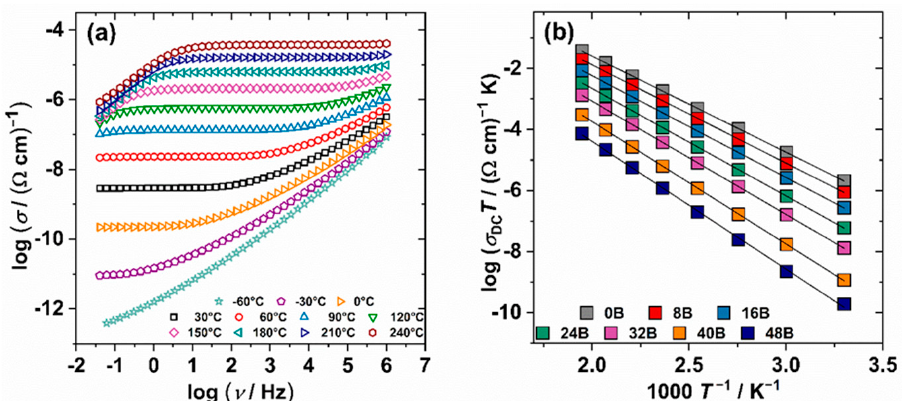
Figure 8. ( a ) Conductivity spectra of 8 mol% B 2 O 3 glass and ( b ) Arrhenius plot of DC conductivity of the (100 − x)[0.4Na 2 O-0.2Nb 2 O 5 -0.4P 2 O 5 ]-xB 2 O 3 glasses. Solid lines represent the least-square linear fits to experimental data.